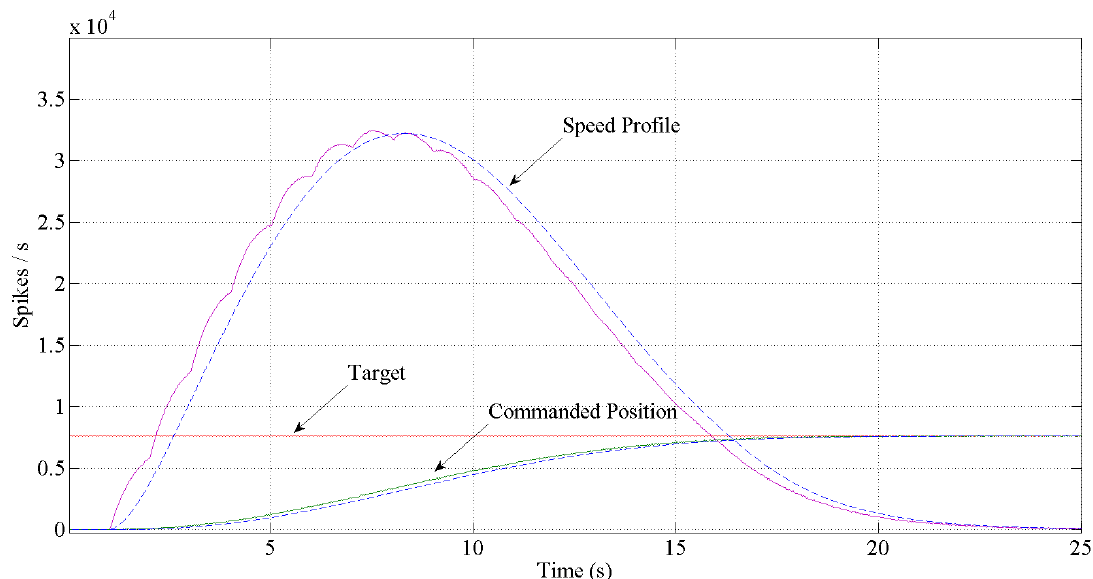
Figure 12. Performance achieved corresponding to one percentage slope in GO signal. Dotted lines are simulated in front of measurement solid lines. The bell shape profile signals represent the speed. The ripple in the spike-base behavior is due to the function that transforms the spikes into a continuous signal. The target is the same for both simulated and measurements signals and it is represented as a firing rate. It takes a total of 17 s to reach the target if we look through the